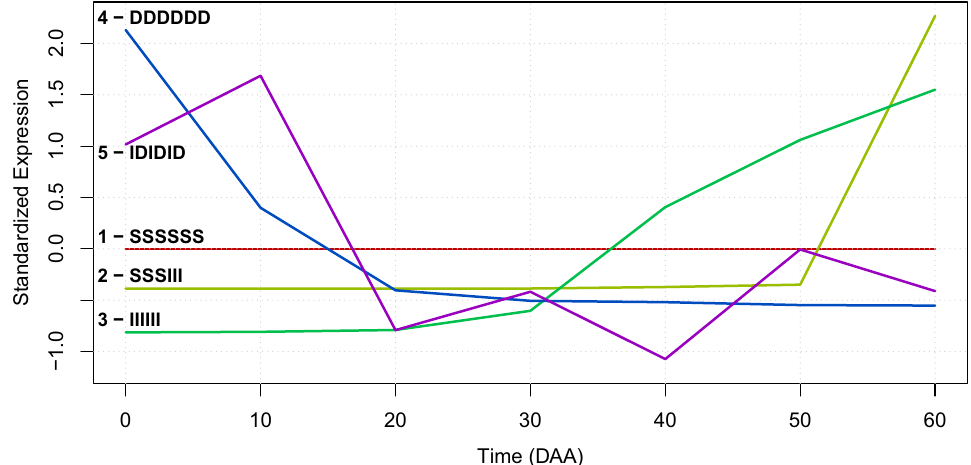
Figure 1. Examples of SEPs with different models ( m i ) for 5 genes in accession “CM”. The number of case and symbolic representation of the model are shown in the legend at the left hand side of the plot for each one of the numeric representations of the SEPs (colored lines; see Table 2 for the description of the protein coded by each gene).